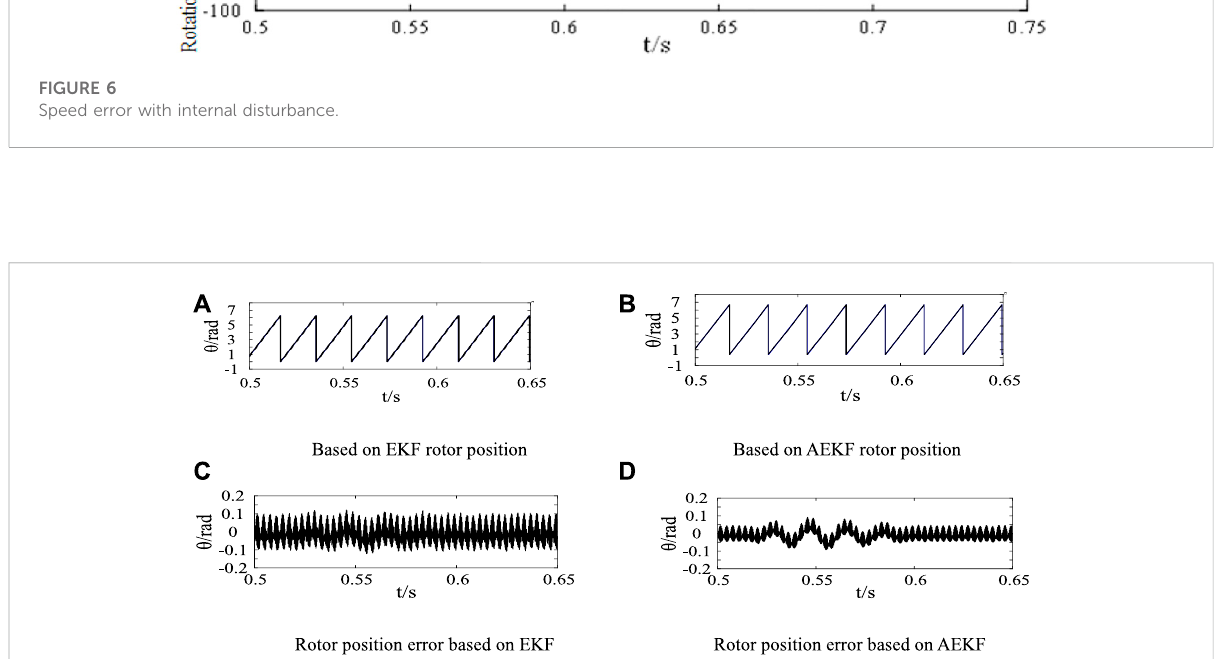
FIGURE 7 Comparison of rotor position under internal interference. (A) Based on EKF rotor position. (B) Based on AEKF rotor position. (C) Rotor position error based on EKF. (D) Rotor position error based on